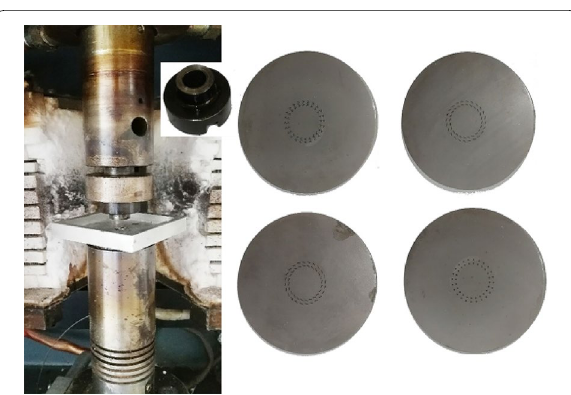
Figure 8 Friction and wear testing machine, 45 steel, and test piece after processing texture